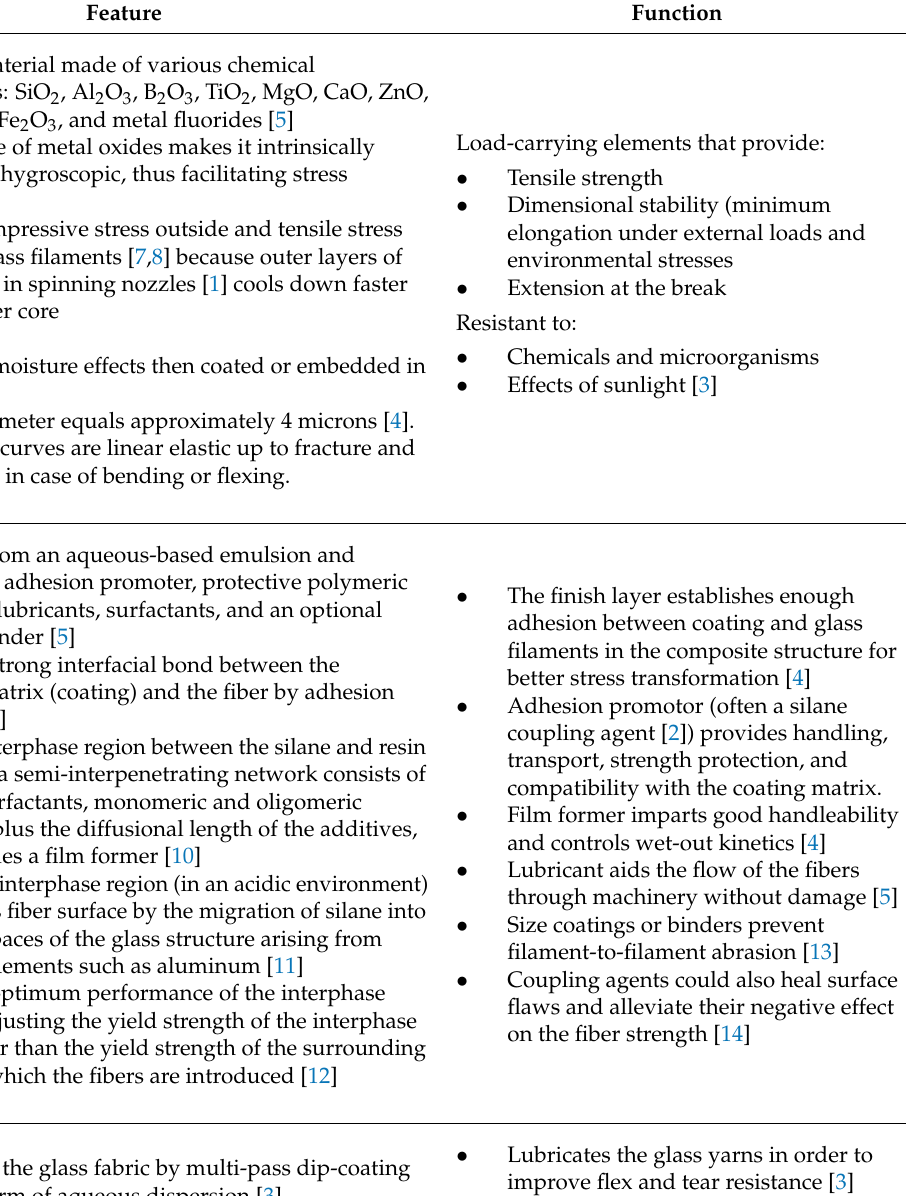
Table 1. Glass-PTFE fabric: different layers and